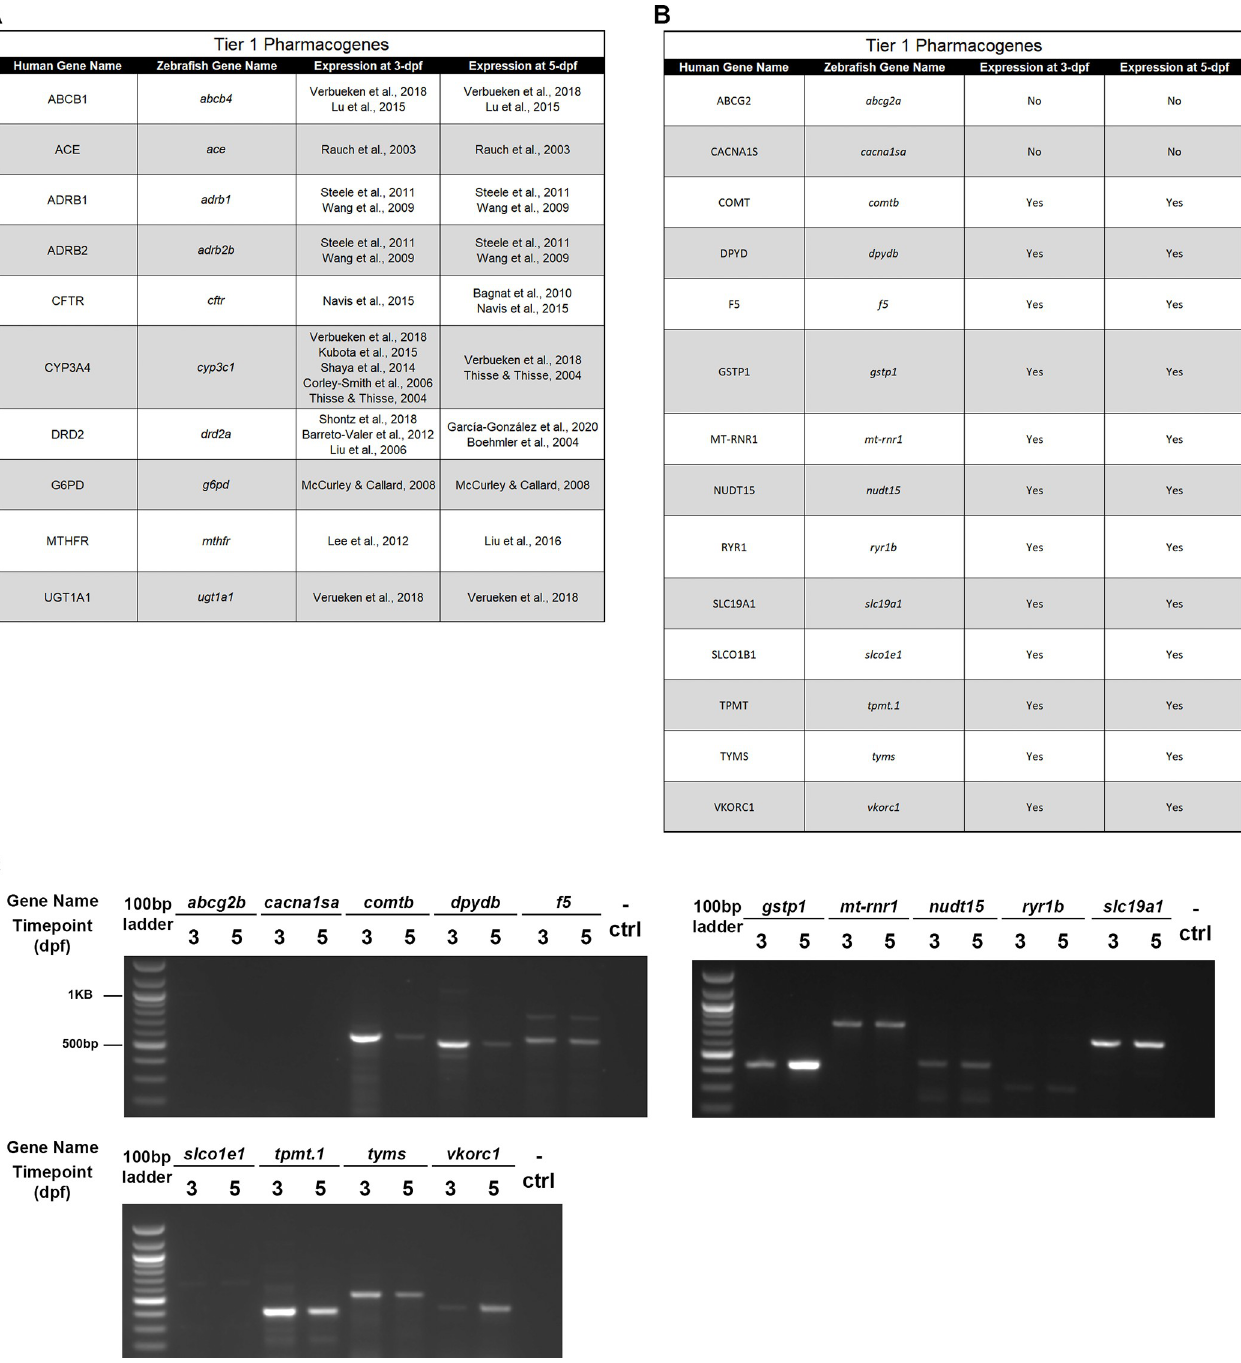
PLOS ONE | https://doi.org/10.1371/journal.pone.0273582 August 30, 2022 7 /